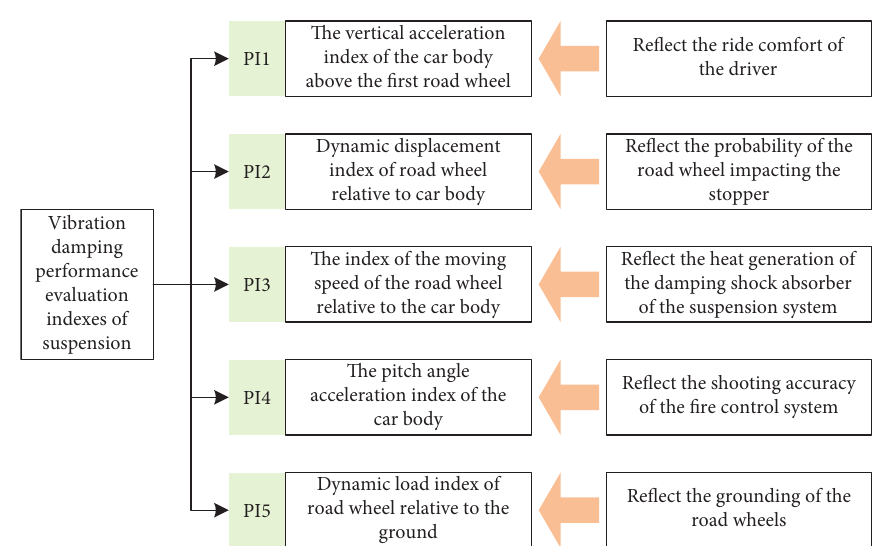
Figure 6: The performance evaluation index for the suspension